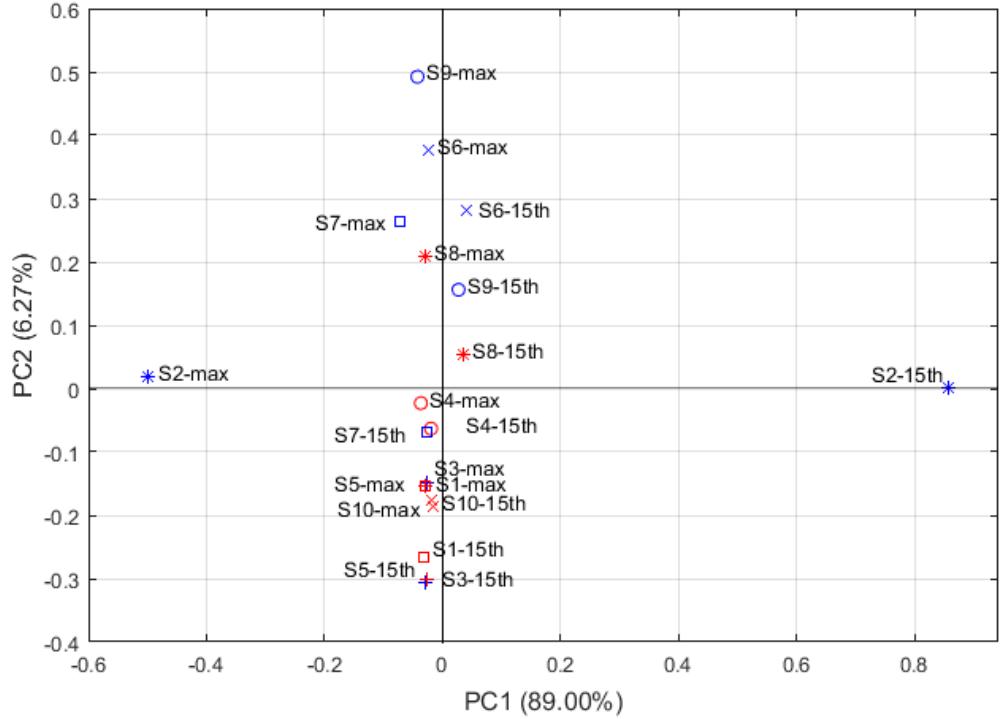
Figure 4. Loading plot of sensors (S1-15th~S10-15th represent the factors of response value of the sensors S1~S10 at the 15th second respectively; S1-max~S10-max represent the factors of maximum response value of the sensors S1~S10 respectively.)